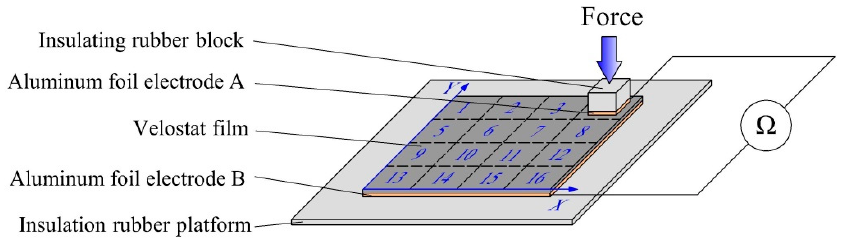
Figure 11. Test device for testing the consistency of the piezoresistive properties of the Velostat film.